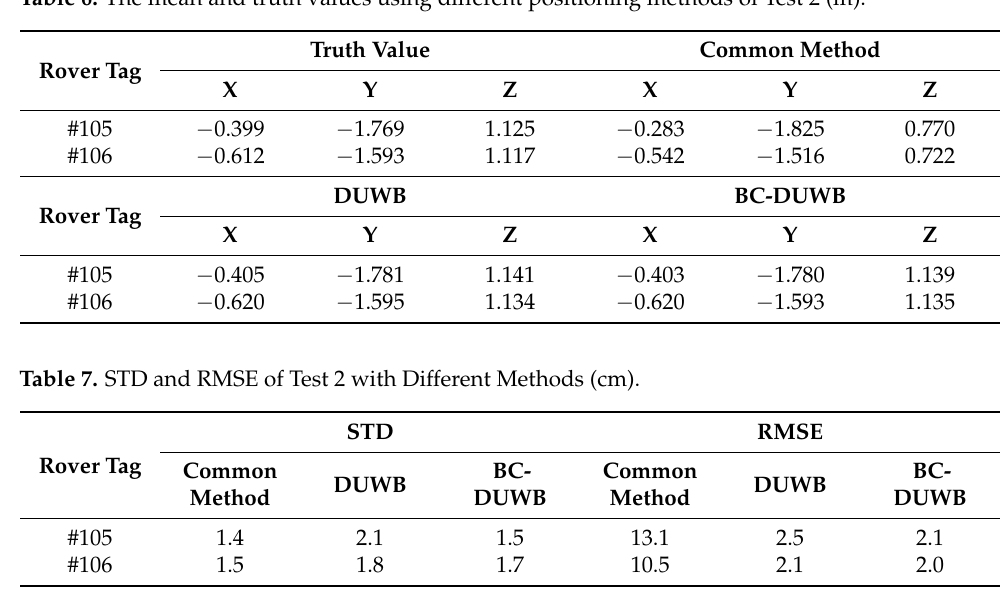
Table 6. The mean and truth values using different positioning methods of Test 2 (m). Rover Tag